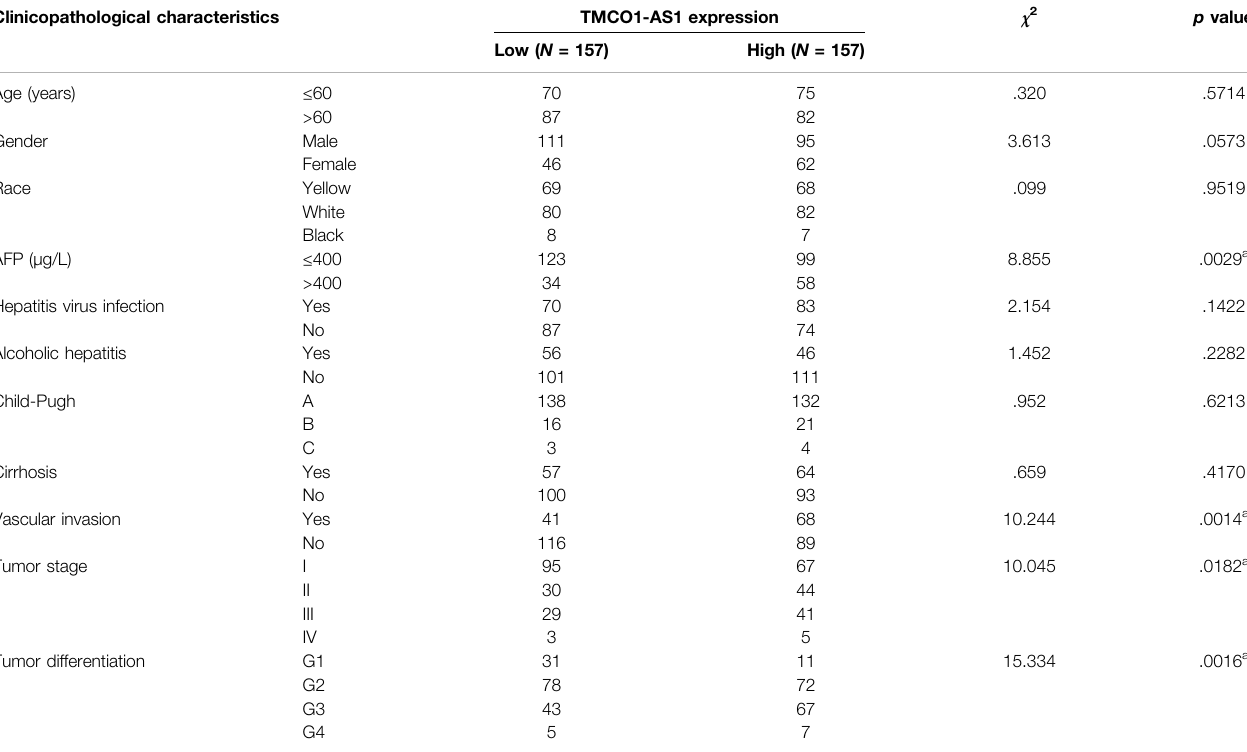
TABLE 1 | Relationship between the expression levels of TMCO1-AS1 and clinicopathological characteristics in 314 HCC patients from TCGA. Clinicopathological